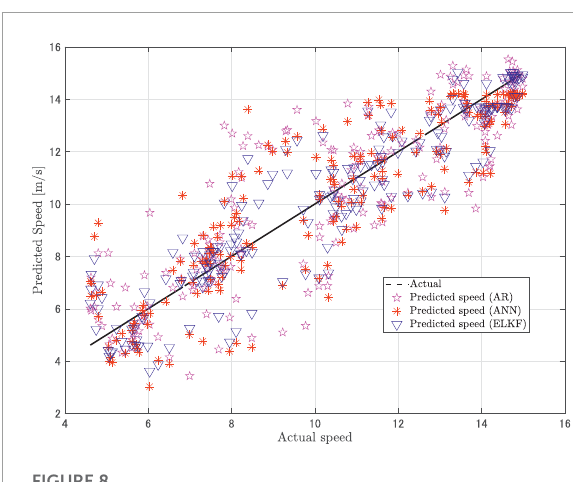
FIGURE 7 Correlation plots of one-step-ahead predictions versus actual values: AR, ANN, and